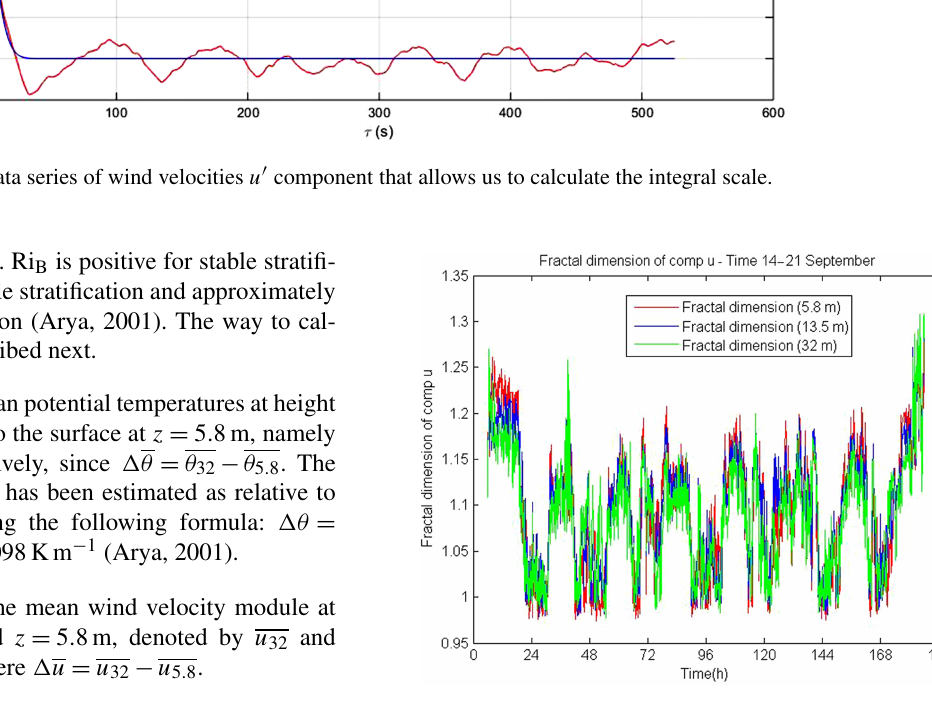
Figure 3. Variation of the fractal dimension vs. time for the u (cid:48) com- ponent fluctuation at the three heights, showing the influence of the diurnal